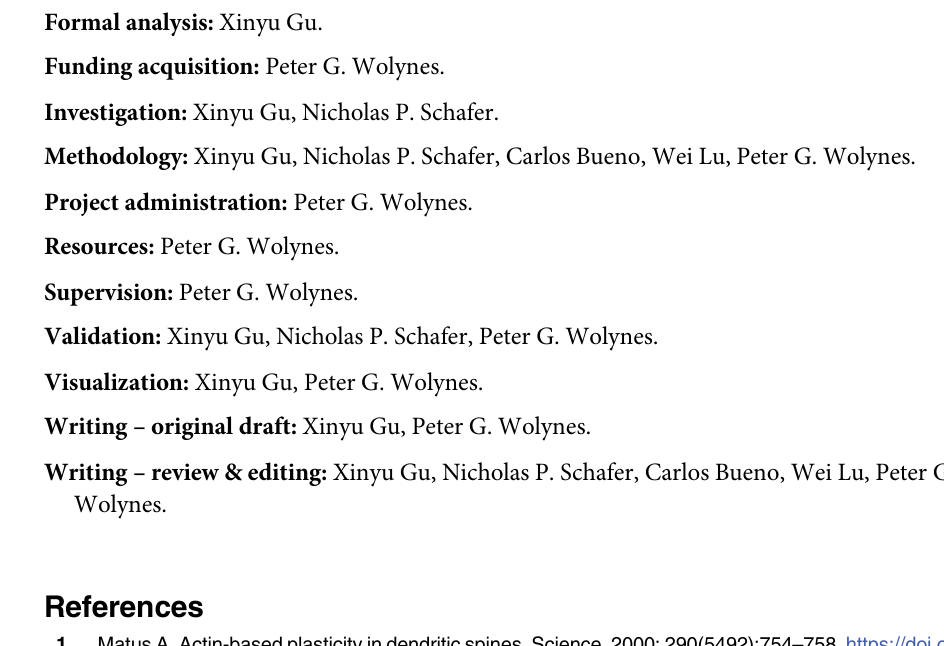
Figure A and B. S6 Fig. A . The 1D Free energy profile for RNA-free RBD and SUMO2/RBD complex using PC0 as the order parameter. B . The 1D Free energy profile for RNA-bound RBD and SUMO2/ RBD complex using PC0 as the order parameter. The free energy of the open state (PC0 equals 10 * 30) is significantly increased upon RBD binding with SUMO2 protein. S7 Fig. The two RNA dissociation pathways from RBD. These correspond with the pathway I and pathway II shown in Fig 5B. The starting point of the dissociation pathways is marked by a white